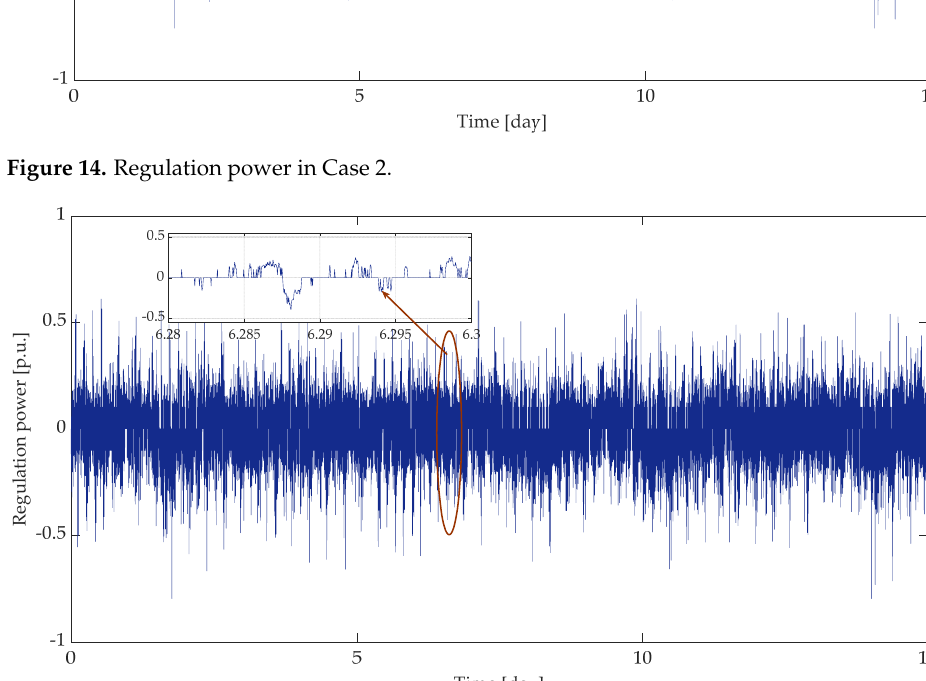
Figure 15. Regulation power in Case 3.